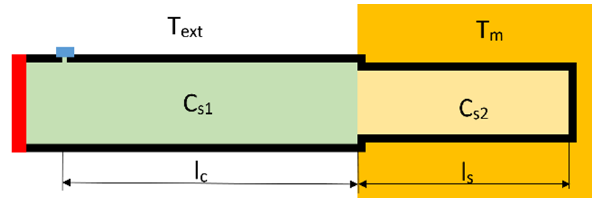
Figure 1. Schematic diagram of single tube practical acoustic thermometer (PAT). The position of the loudspeaker is marked in red and the position of the microphone is marked in blue.